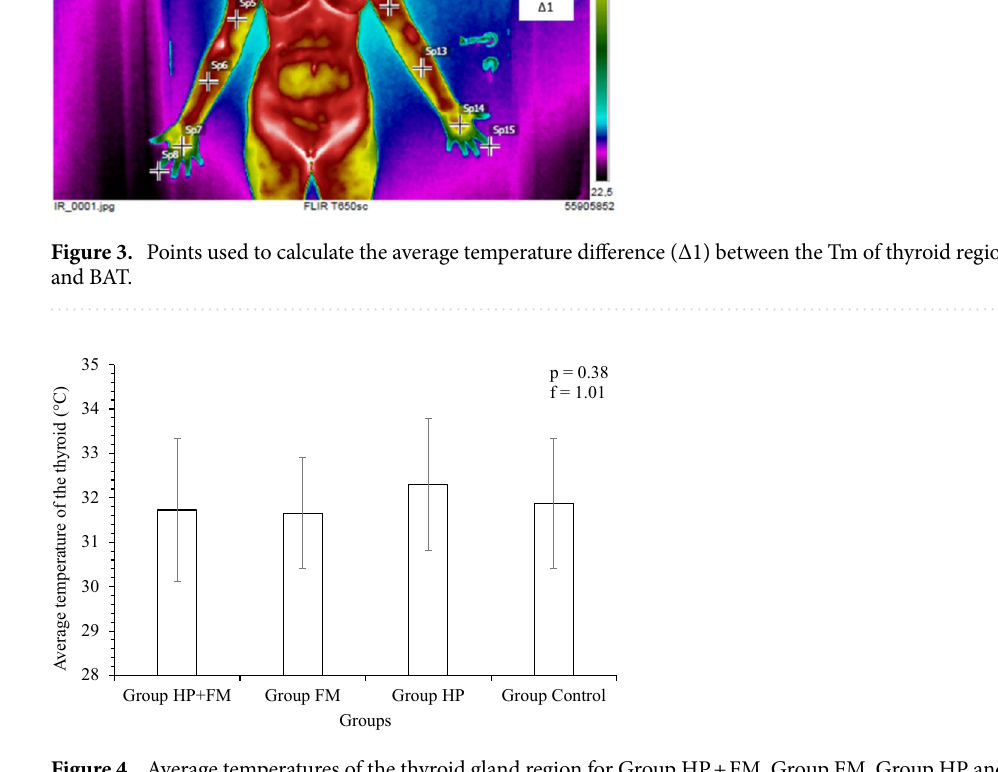
Figure 4. Average temperatures of the thyroid gland region for Group HP + FM, Group FM, Group HP and Group